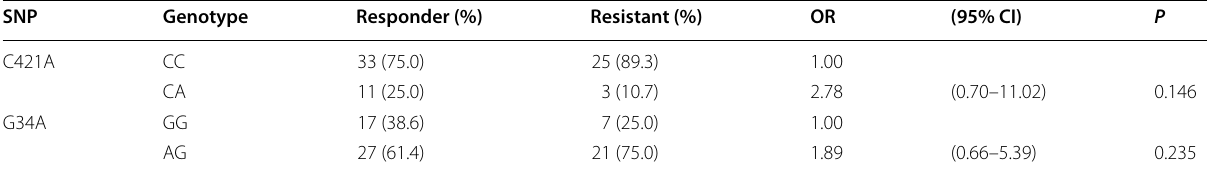
Table 2 C421 and G34A genotype frequencies in the responder and resistant groups